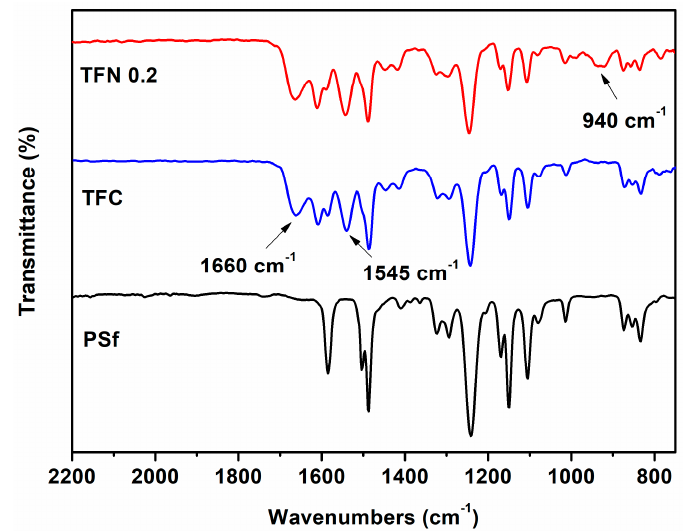
Figure 2. ATR-FTIR spectra of PSf substrate, thin film composite (TFC) membrane and thin film nanocomposite (TFN) 0.2 membrane.